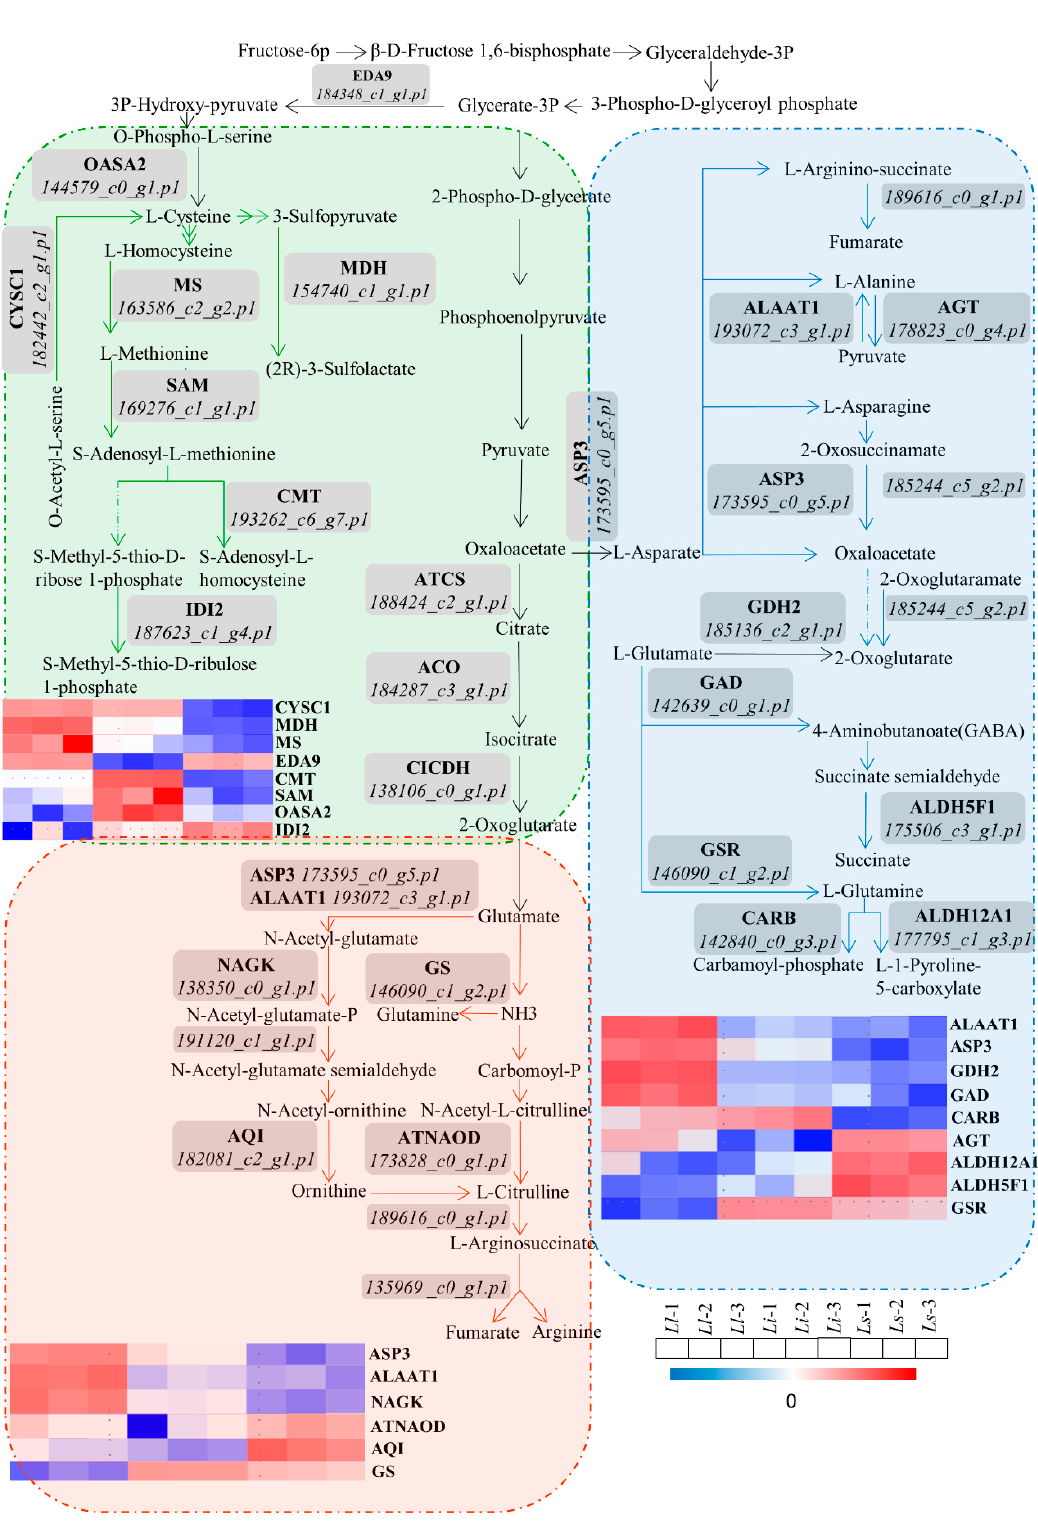
Figure 3. Amino acid metabolism is closely related to the biosynthesis of Amaryllidaceae alkaloids in Lycoris . We detected a total of 38 differential proteins in the amino acid metabolism pathway. The highly expressed proteins were mainly concentrated in Ll, which was consistent with the actual detected trend of alkaloid content of the three varieties.